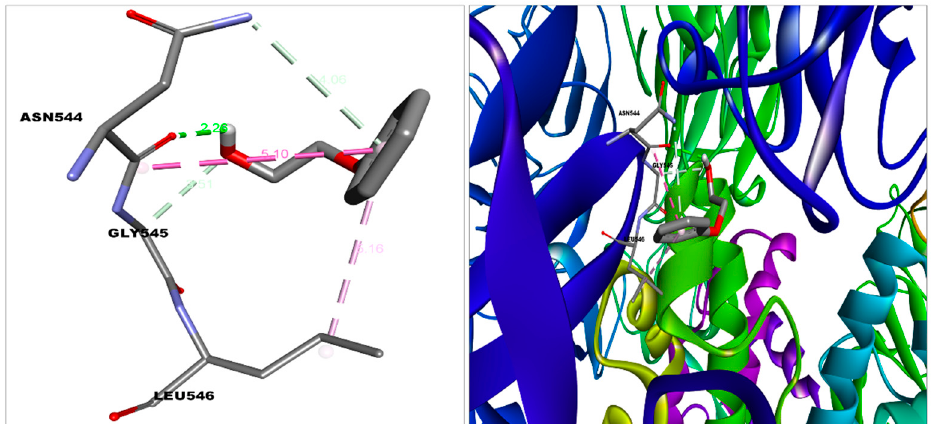
Figure 5. Imidazoquinolinone in a docked position in the binding pocket of HSA.This figure was produced using Discovery Studio Visualizer (http://accelrys.com/products/collaborative-science/biovia-discovery-studio/visualization-download.php).